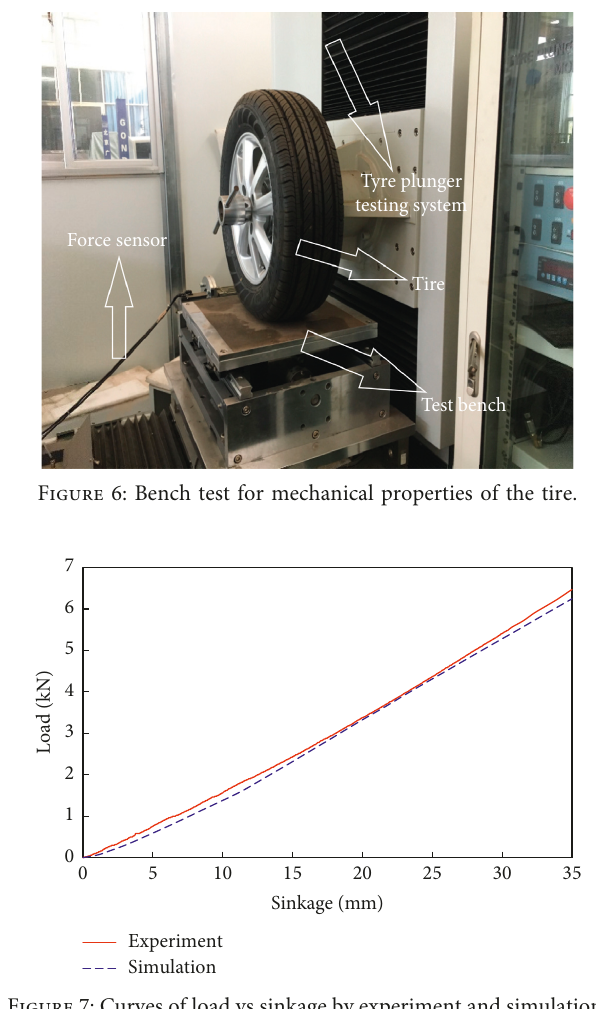
Figure 7: Curves of load vs sinkage by experiment and simulation.